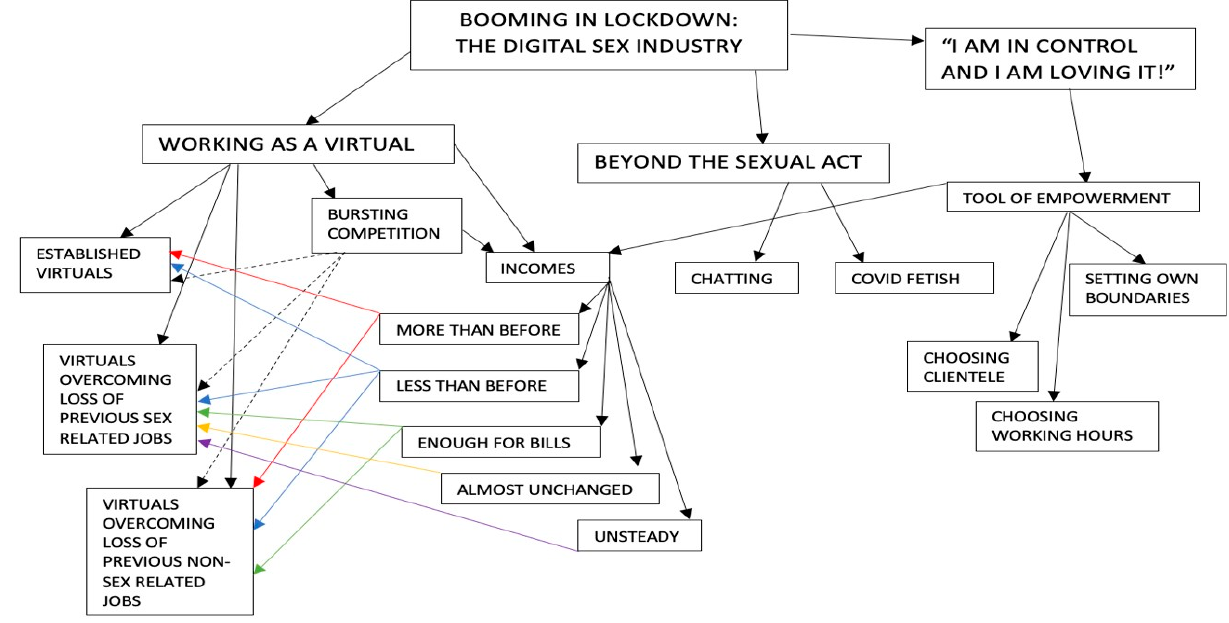
Figure 1. Diagram of the core category, subcategories, properties and dimensions.